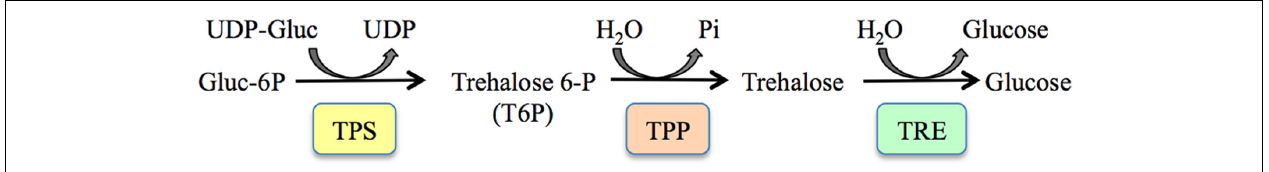
FIGURE 1 |Trehalose metabolism. Trehalose-6-phosphate synthase (TPS) converts glucose-6-phosphate and UDP-glucose into trehalose-6-phosphate (T6P). T6P is dephosphorylated into trehalose by trehalose-6-phosphate phosphatase (TPP), and then hydrolyzed into two glucose molecules by trehalase (TRE).